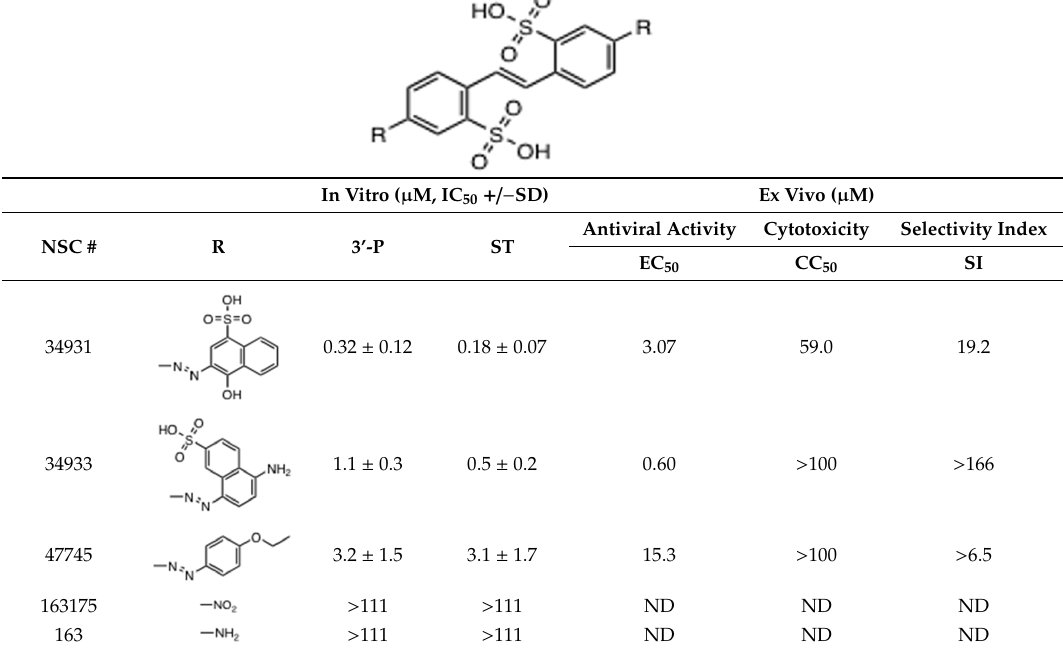
In Vitro (µM, IC 50 +/ − SD)